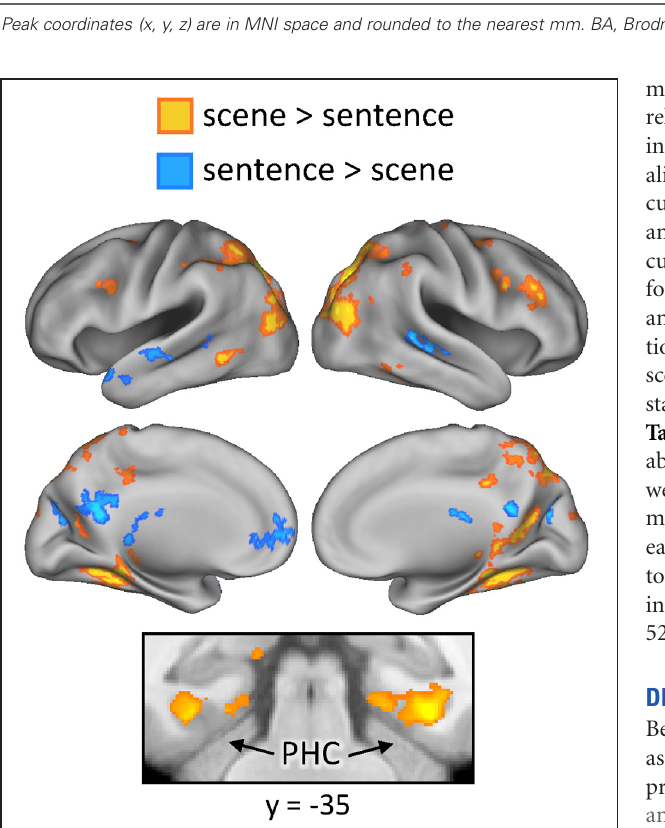
FIGURE 5 | Regions exhibiting content-sensitive differences during the study phase. Warm colors indicate enhanced activity for the scene condition; cool colors indicate enhanced activity for the sentence condition. PHC (parahippocampal